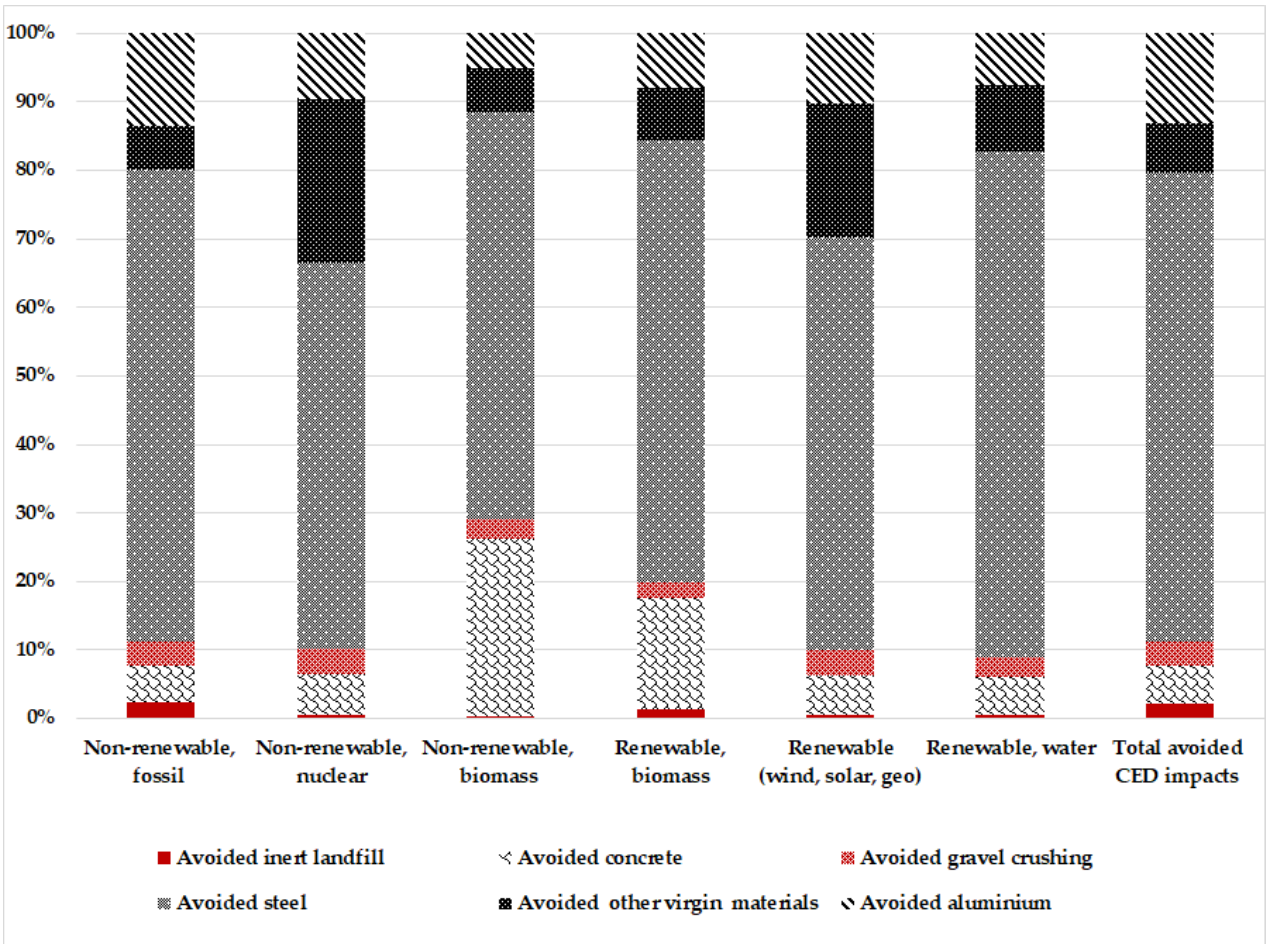
Figure 5. Percentage values of avoided CED impacts associated to the collection and recycling of 1 tonne of C&DW.